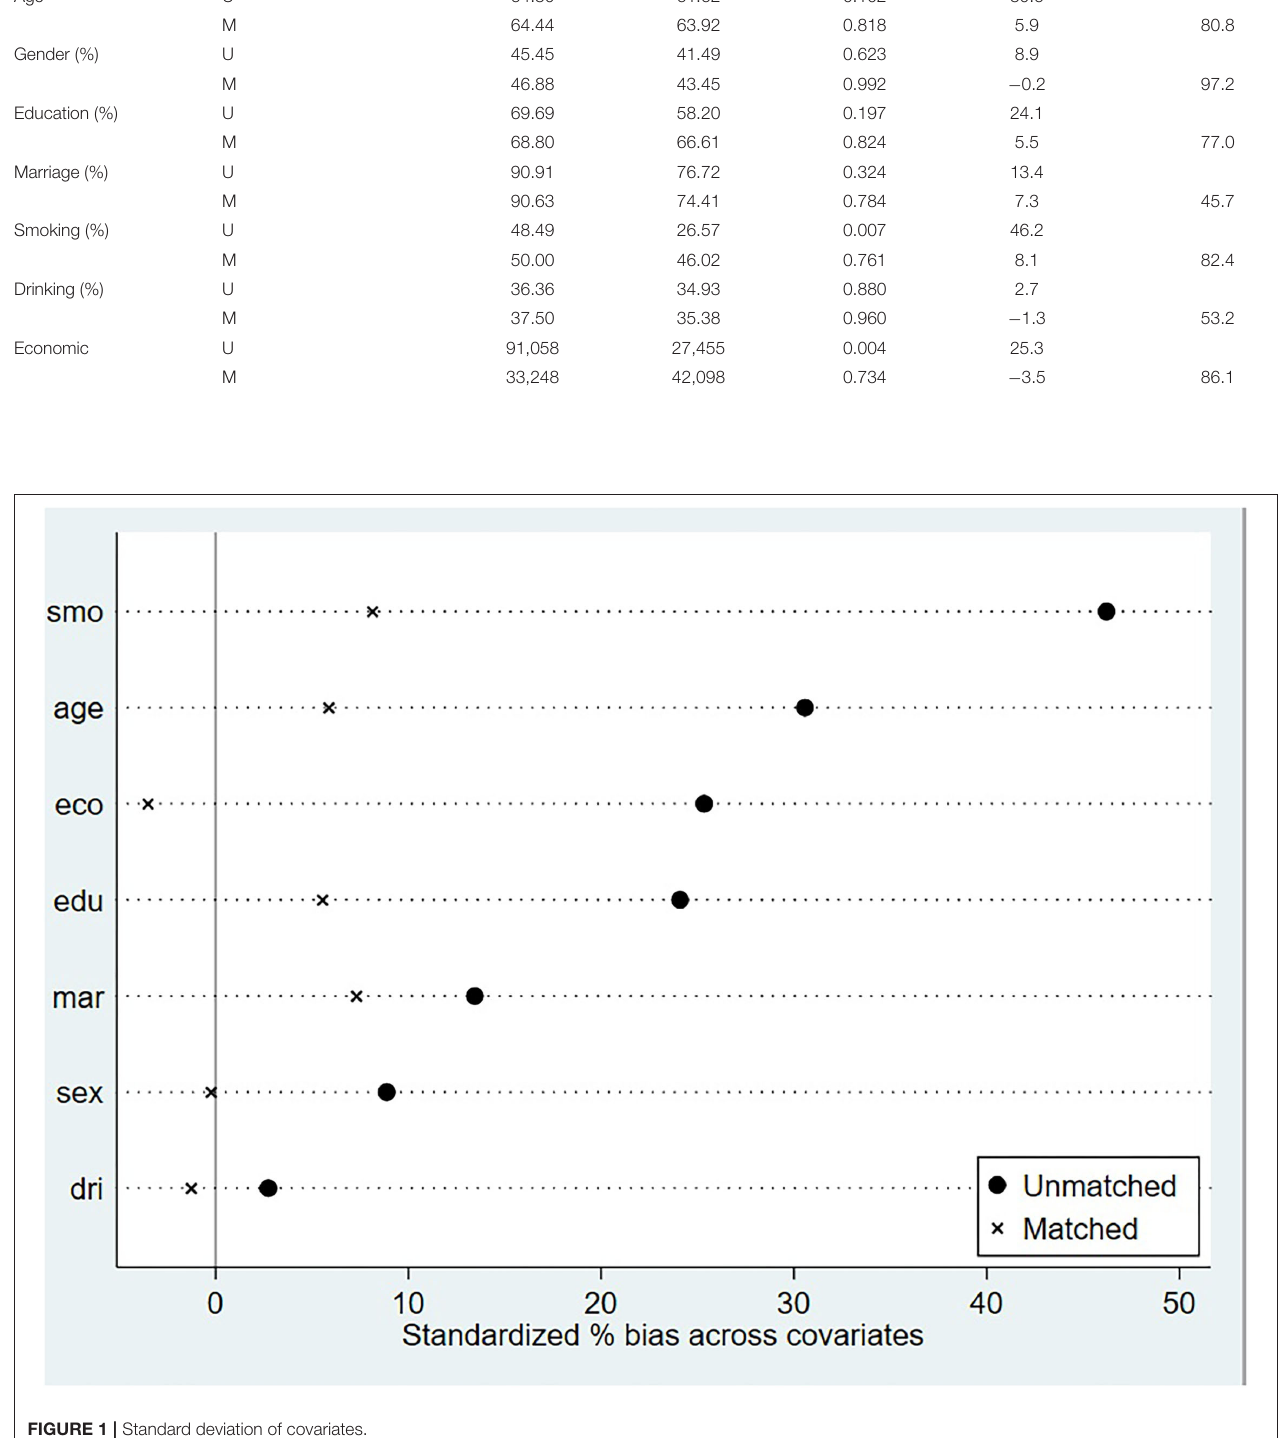
FIGURE 1 | Standard deviation of